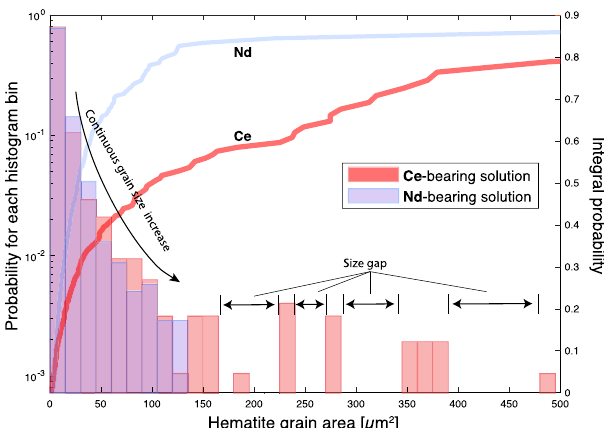
Fig. 4 Grain size distribution of newly formed hematite. The fi gure shows the crystal size of hematite formed in Ce-bearing and in Nd-bearing solutions from non-oxidative runs. The lines show the integral probability of hematite grain size. The probability of fi nding larger grain sizes decreases up to 150 µ m 2 in both Ce and Nd-bearing solutions; however, a signi fi cant amount of hematite in the Ce-bearing solutions occurs as crystals larger than 150 µ m 2 , with large gaps in observed crystal